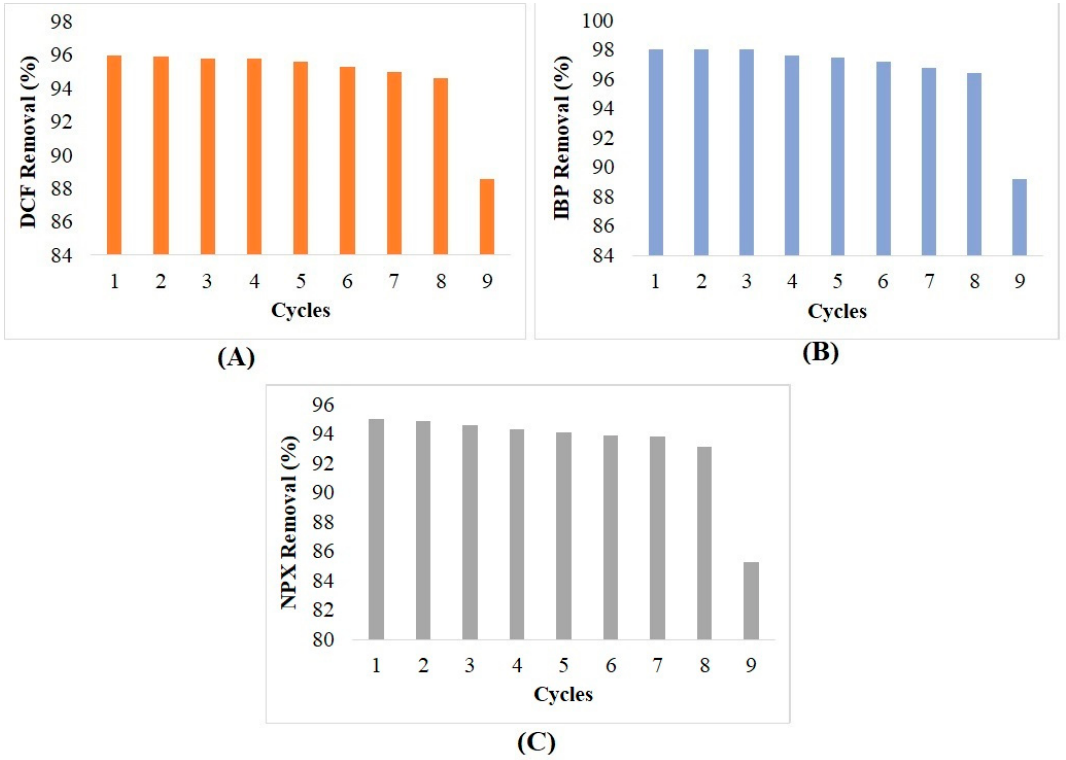
Figure 12. Regeneration results of CMCAB during removal of DCF ( A ), IBP ( B ) and NPX ( C ).